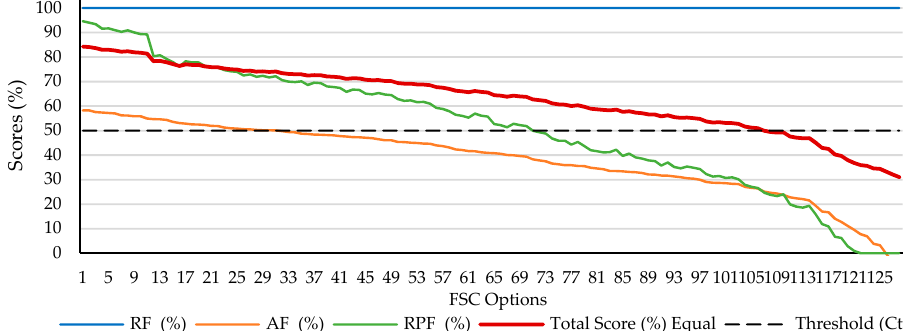
Figure 16. Graphical presentation of all FSCs that satisfy the load demand at 37.9 kWh/day.